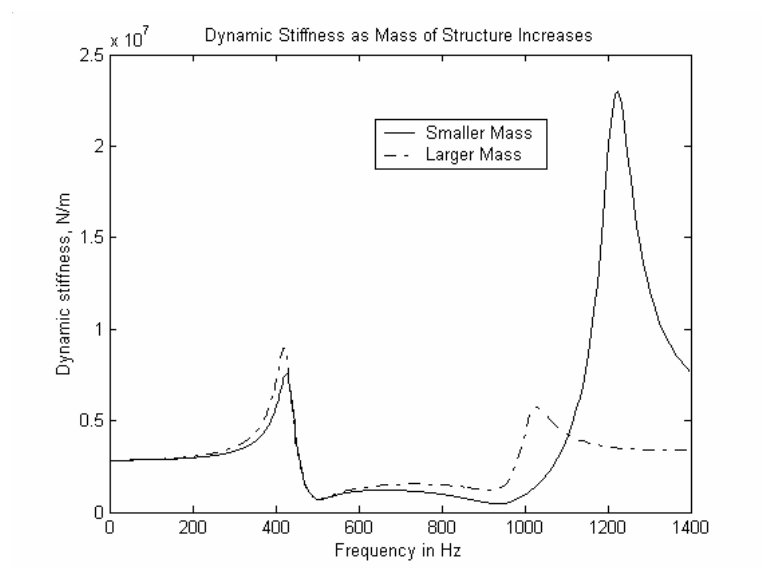
Fig. 15. Dynamic stiffness as structure mass is